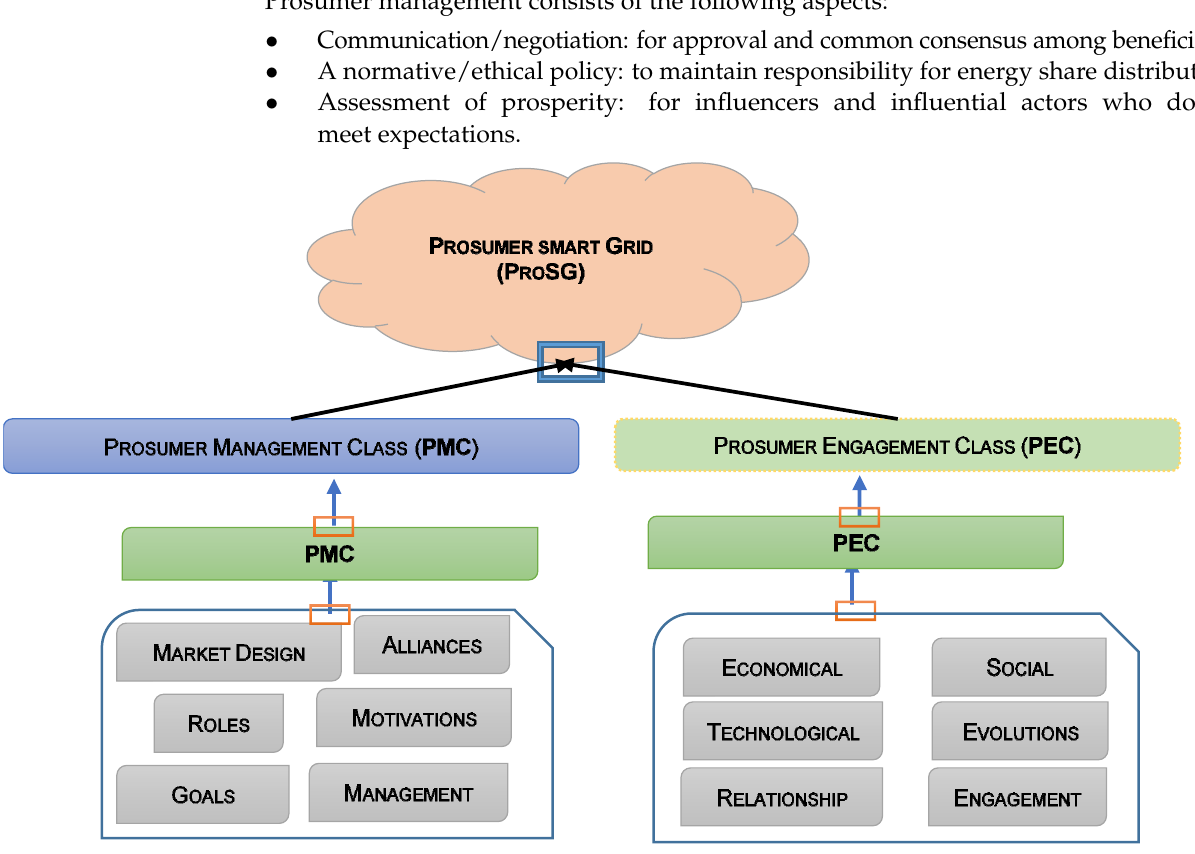
Figure 4. Smart grid Prosumer classes.